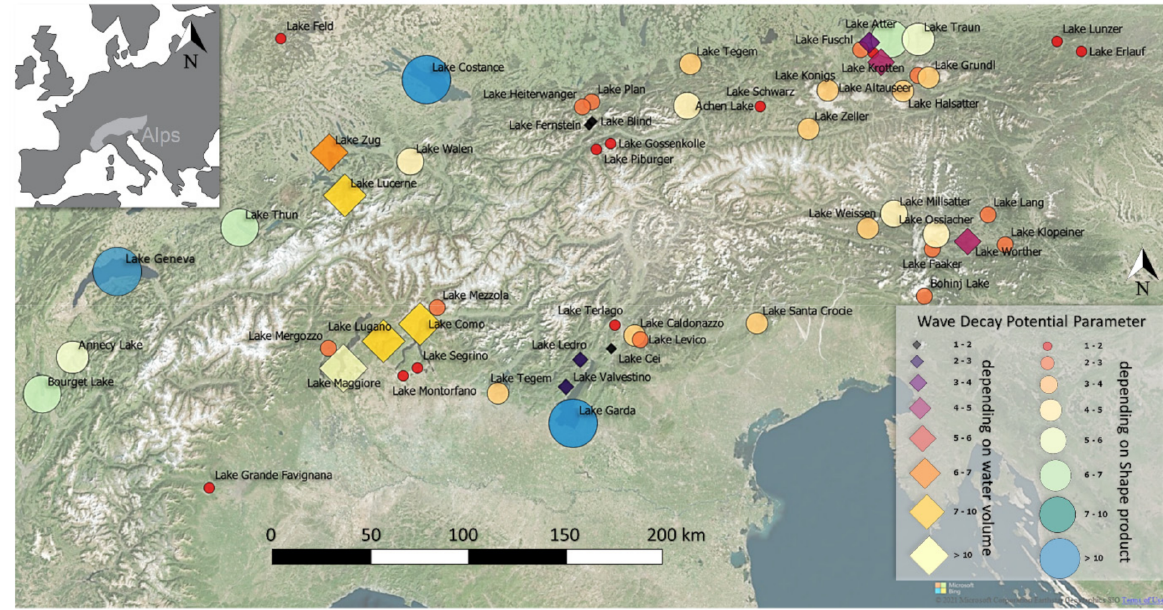
Figure 12. Alpine and perialpine lakes considered in this study and related WDPP values obtained using the ShpP relation (circles in the legend). Where ShpP is unavailable, WDPP was obtained using the water volume relation (squares in the legend, see also Figure 7b). Topographical background taken from Microsoft Bing Maps—2021 Microsoft Corporation Earthstar Geographics Sio (Accessed on 26 July